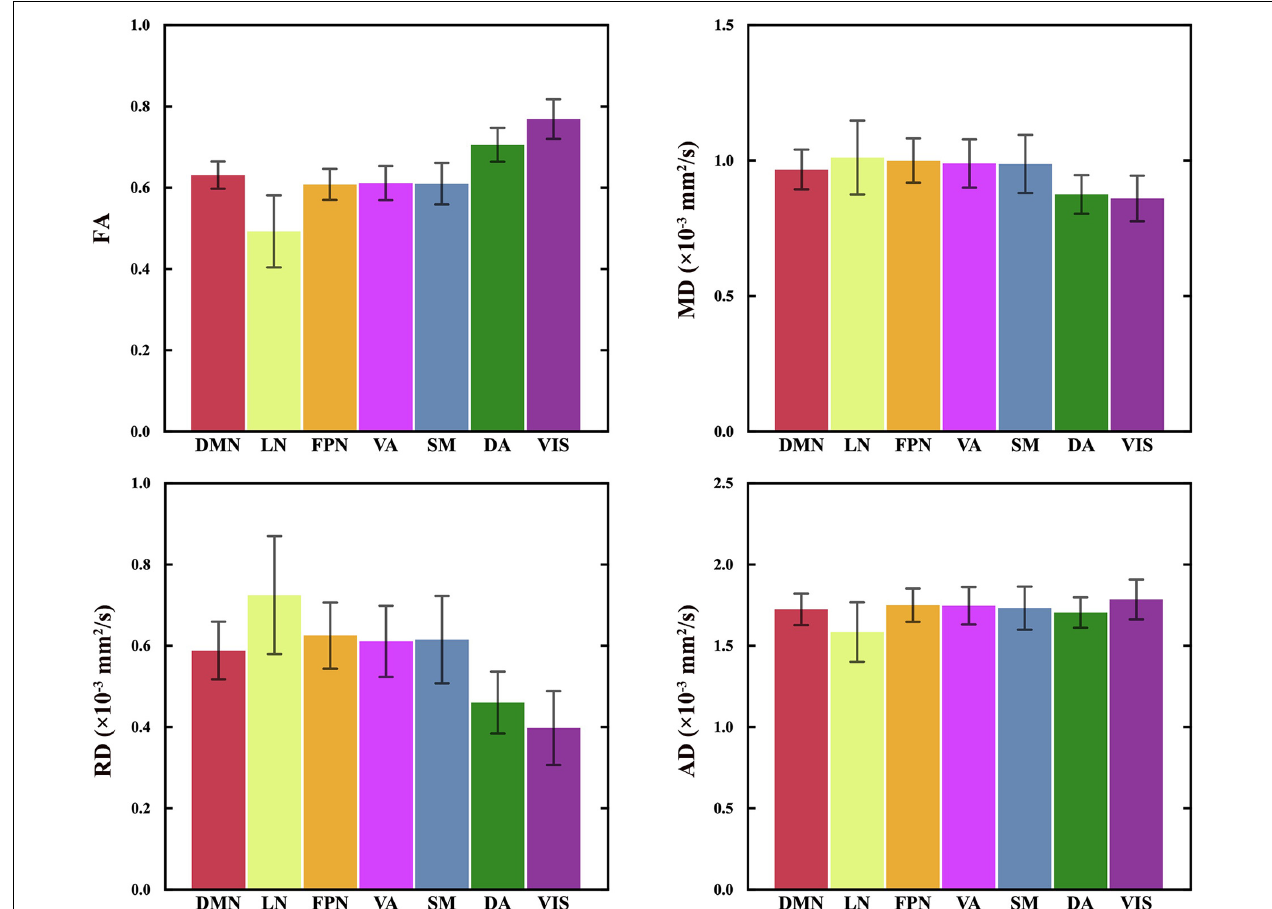
FIGURE 2 | The diffusion indices of 7 CC subregions. The mean and standard deviation of the regressed D I ( s , n ) of all participants are plotted in the order of the spatial locations of all CC subregions, generally from the anterior to posterior part in the CC. RM-ANOVA showed significant differences in FA, MD, AD and RD between the CC subregions. FA values of the CC subregion connecting to VIS and DA are statistically higher than other subregions. MD and RD values of the CC subregions connecting to VIS and DA are statistically lower than those of other subregions. See Supplementary Table 1 for the details of the statistical analysis of paired comparisons. VIS, CC subregion connecting to the visual network; SM, CC subregion connecting to the somatomotor network; DA, CC subregion connecting to the dorsal attention network; VA, CC subregion connecting to the ventral attention network; LN, CC subregion connecting to the limbic network; FPN, CC subregion connecting to the frontoparietal network; DMN, CC subregion connecting to the default mode network; FA, fractional anisotropy; MD, mean diffusivity; RD, radial diffusivity; AD, axial